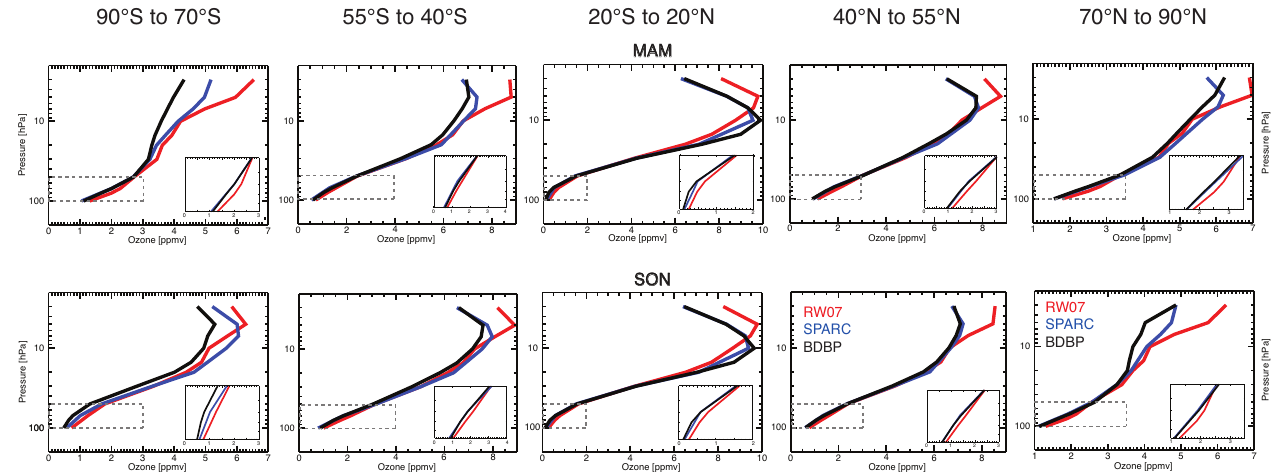
Fig. 2. Climatological ozone profiles from the three ozone data sets for five latitude regions (first column: 90 ◦ S to 70 ◦ S, second column: 55 ◦ S to 40 ◦ S, third column: 20 ◦ S to 20 ◦ N, fourth column: 40 ◦ N to 55 ◦ N, fifth column: 70 ◦ N to 90 ◦ N) and two seasons (upper row: MAM, lower row: SON). The lower stratosphere part of the profile (100hPa to 50hPa, grey dashed box) is expanded in the small inset in each